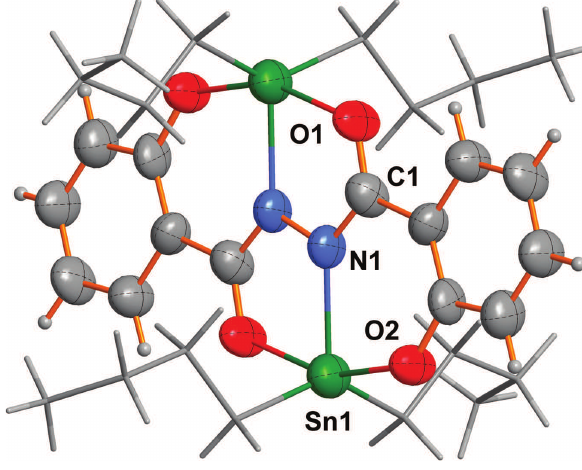
Table 1: Data collection and